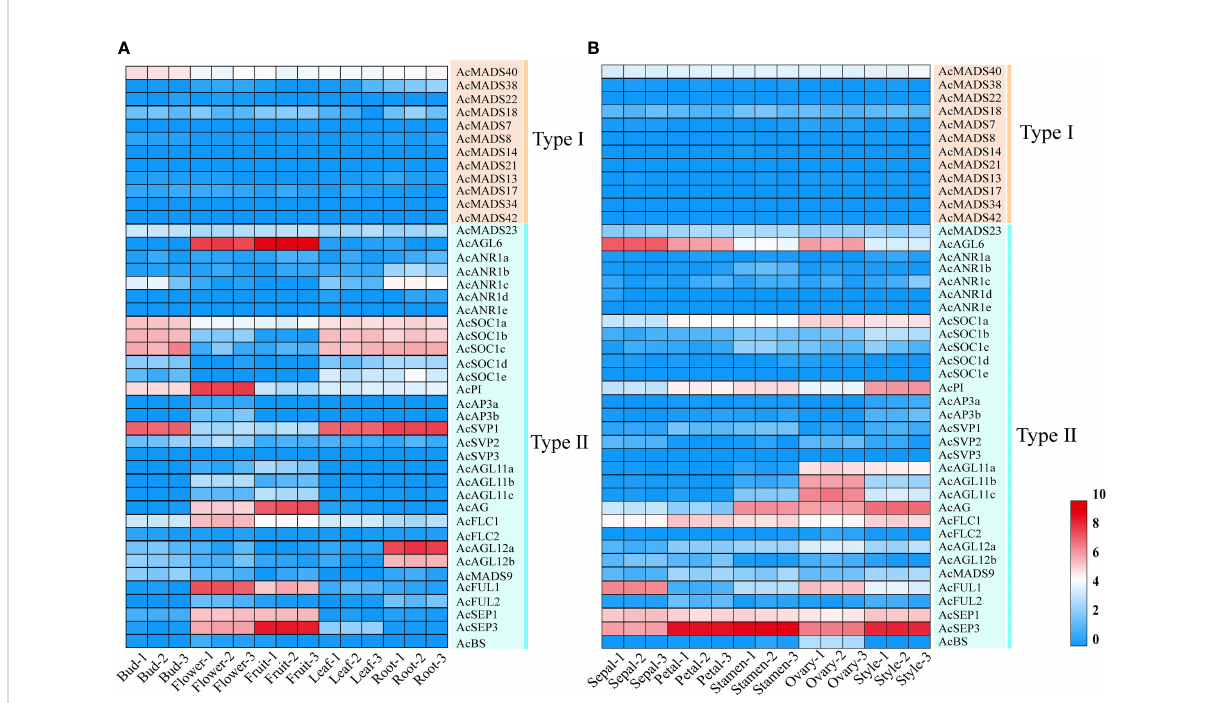
FIGURE 7 Expression patterns of the pineapple MADS genes, the transcript abundance of AcMADSs was computed by FPKM values. (A) Hierarchical clustering of the expression patterns of AcMADS genes in the different tissues of pineapple. (B) Expression pro fi les of AcMADS genes in pineapple fl oral